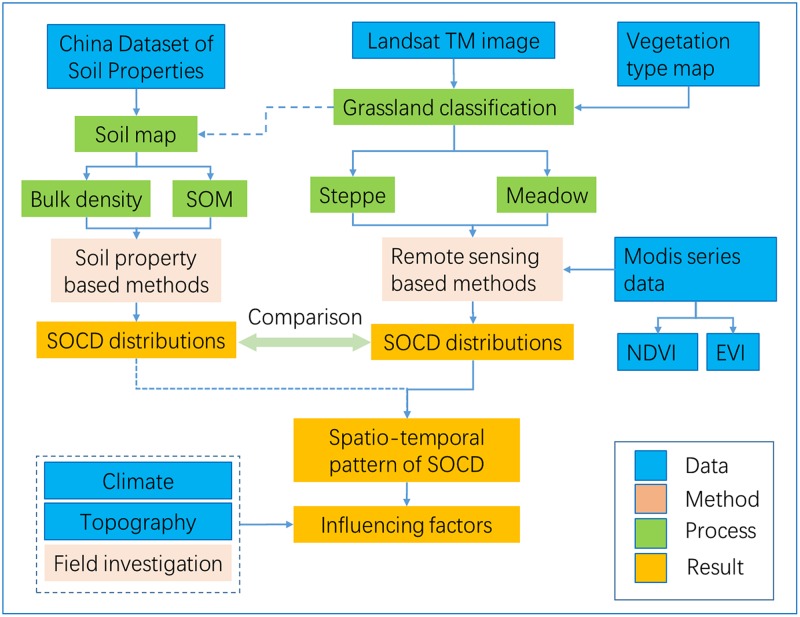
The technical route in this study.